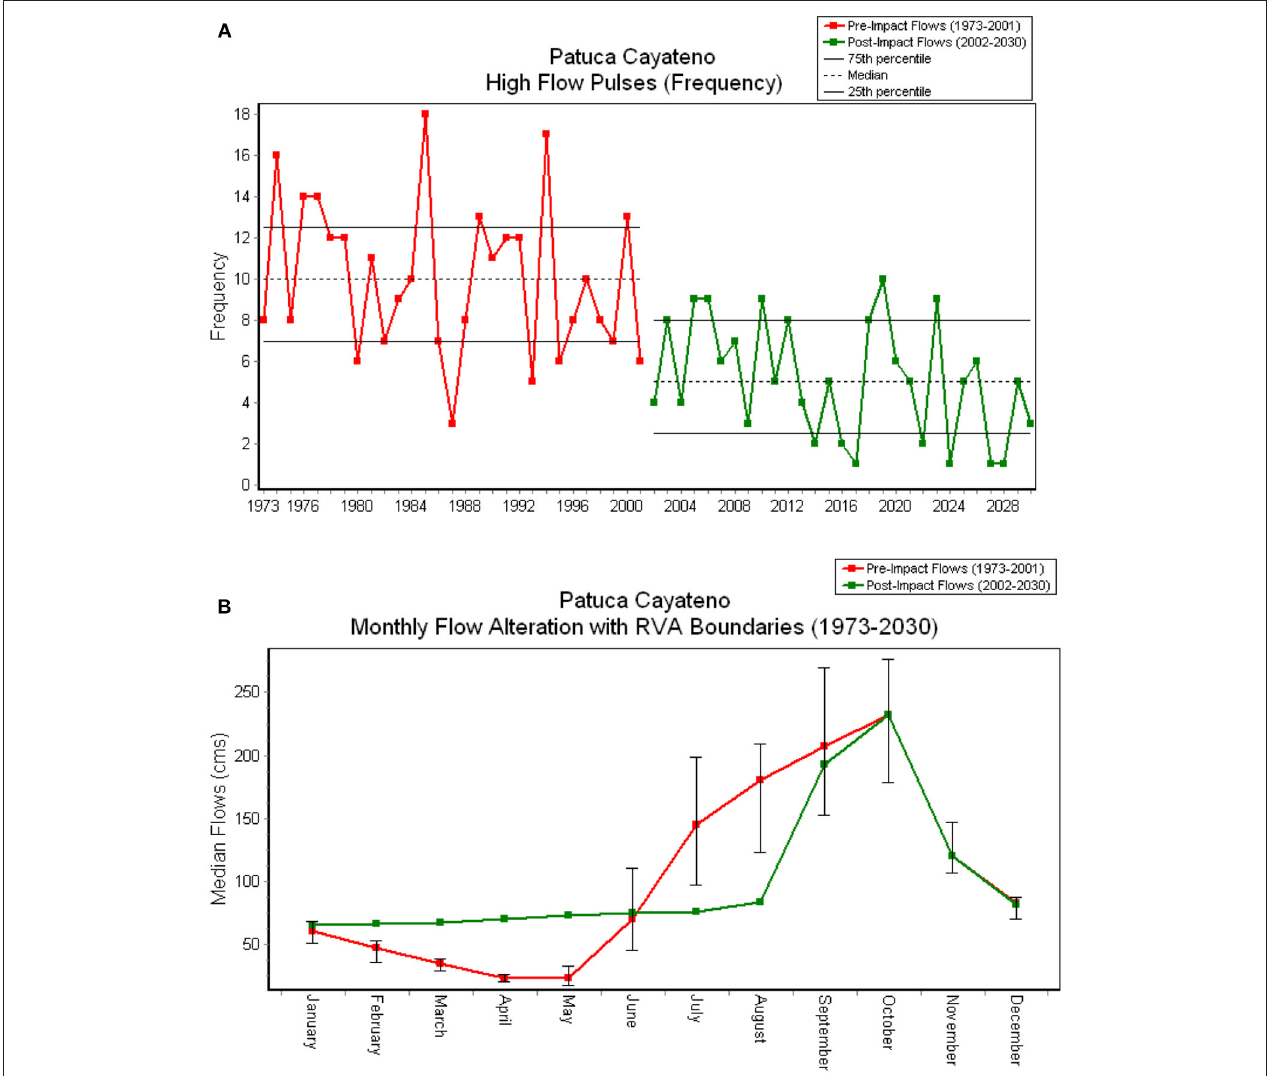
FIGURE 2 | Output from the software Indicators of Hydrologic Alteration (IHA) for the Patuca River, Honduras. The red lines show natural (“pre-impact”) flows from 1973 to 2001 while the green lines show the “post-impact” flows. Note that in this case the dam on the Patuca River has not been built yet and the “post-impact” flows are actually the same flow data set (1973–2001) run through a model simulating flows with dam operations. Thus, the years 2002–2030 do not actually represent future years but are given those dates because of how IHA processes data. Panel (A) shows that the dam will reduce the frequency of high-flow pulses from ∼ 10 per year to 5 per year because the reservoir will be refilling during the initial onset of the rainy season (June through August), as shown in (B) , when high-flow pulses tend to occur. Flow recommendations were developed based on these hydrological analyses combined with a literature review on tropical lowland rivers and an expert panel workshop (Esselman and Opperman, 2010).